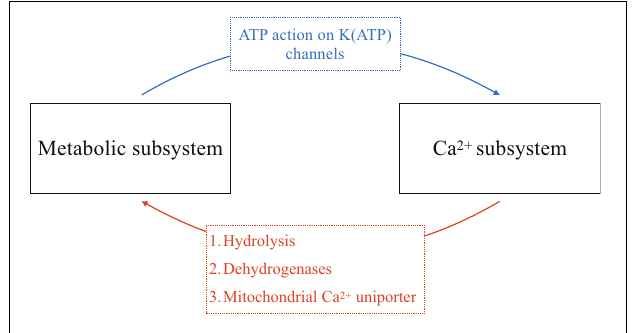
FIGURE 2 | Schematic of the symbiosis of electrical and metabolic oscillators. The ways that one subsystem affects the other is indicated on the arrows.